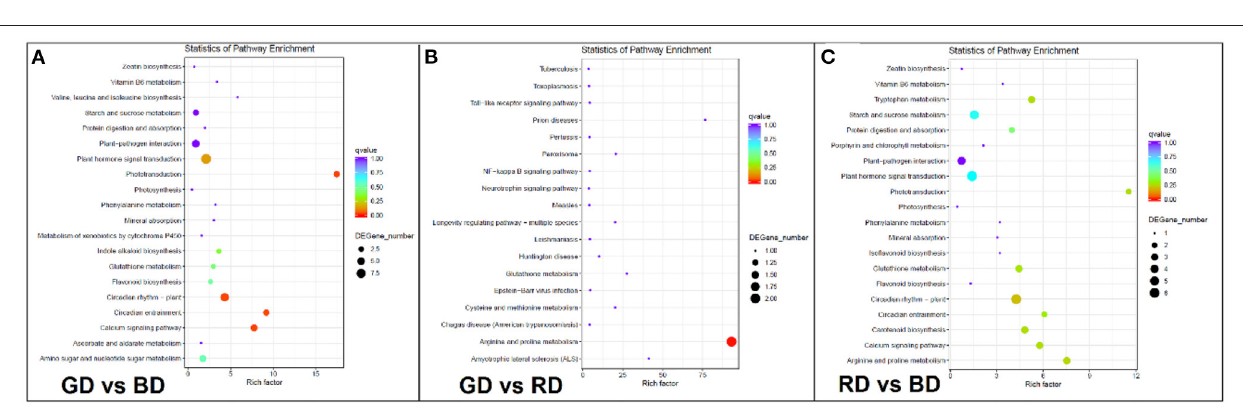
FIGURE 6 | KEGG pathway enrichment analysis of the annotated DEGs in the comparisons of GD vs BD (A) , GD vs. RD (B) , and RD vs. BD (C) . The Y-axis indicates the KEGG pathway, while the X-axis presents the enrichment factor, which is the ratio of DEGs enriched to specific KEGG pathways to DEGs enriched to all KEGG pathways. The dot size and the dot color indicate the number of DEGs of the pathway and q value, respectively.